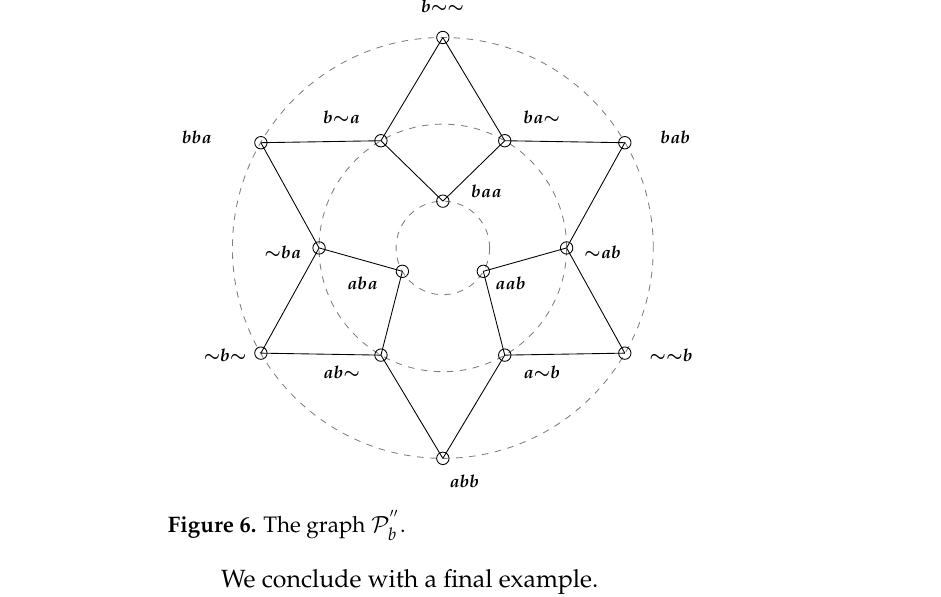
. (cid:48)(cid:48) b P